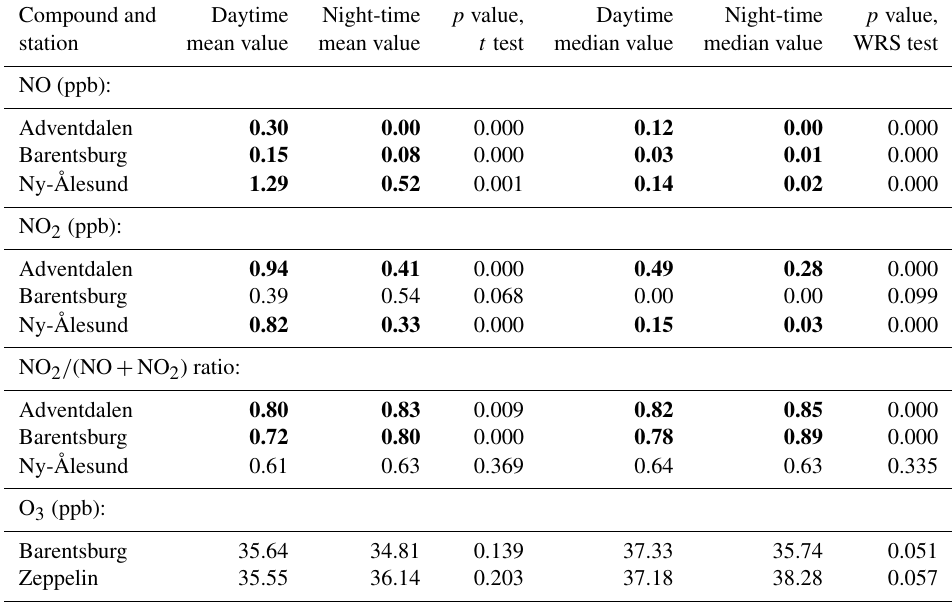
Table 1. Measurement results from Adventdalen, Barentsburg and Ny-Ålesund. The two-sided t test compares daytime and night-time concentrations at each station and checks if there is a significant difference in mean values for these two groups. The two-sided WRS test compares daytime and night-time concentrations at each station and checks if there is a significant difference in median values for these two groups. Pairs with significant ( p < 0 . 05) t and WRS test results are shown with bold font. Compound and Daytime p value,